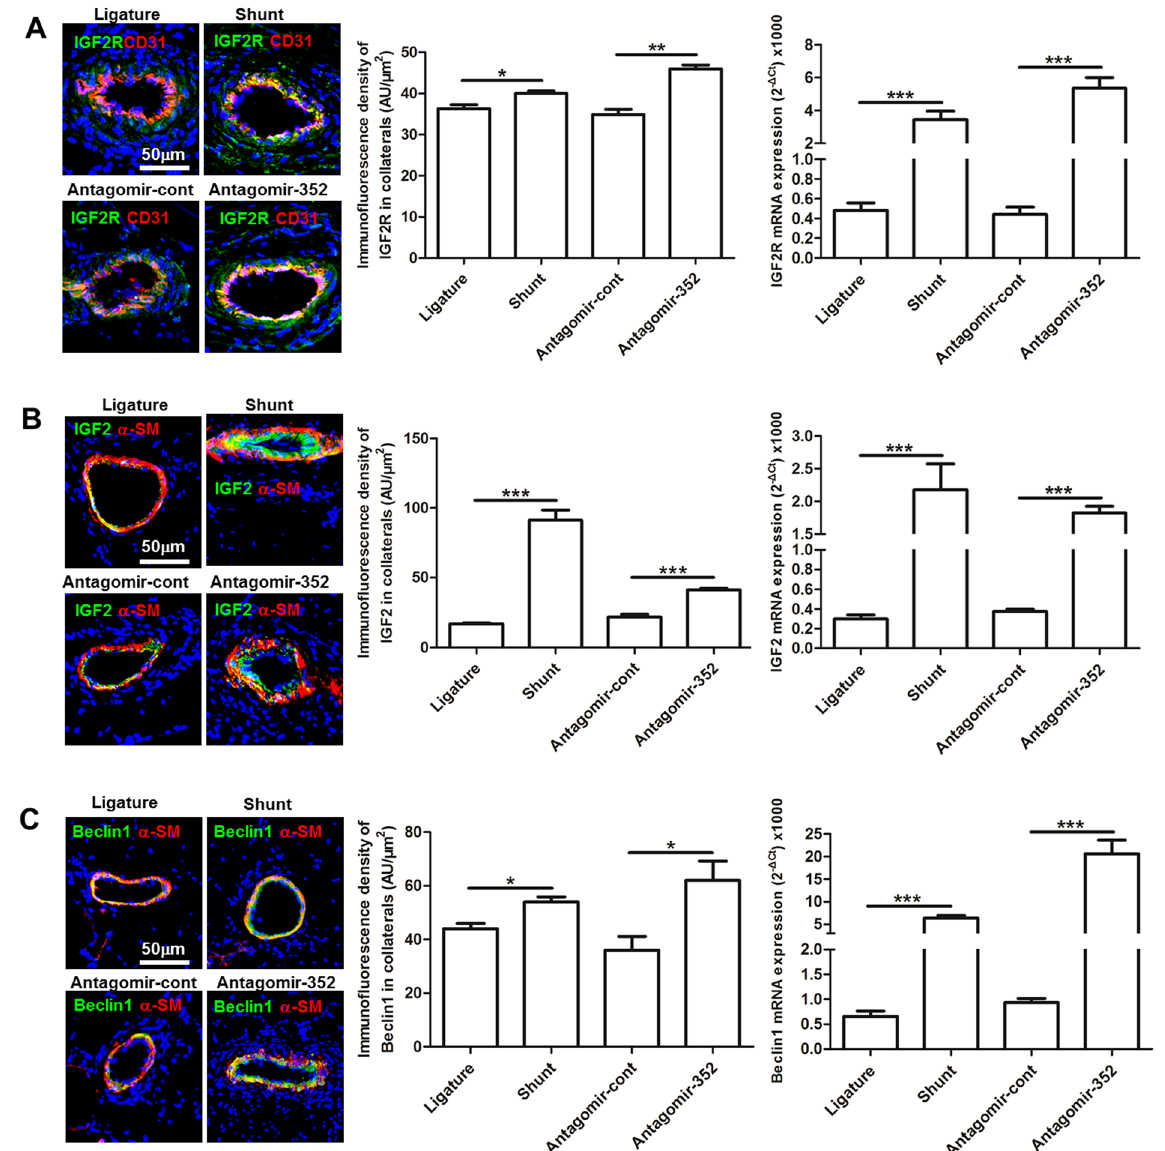
Figure 6. Effect of FSS and antagomir-352 on the expression of IGF2R, IGF2 and Beclin1 in collateral vessels of rat hind limbs. ( A ) IGF2R immunostaining and qPCR. ( B ) IGF2 immunostaining and qPCR. ( C ) Beclin1 immunostaining and qPCR. Specific fluorescence in green; red fluorescence for CD31 in A and for α -SM-actin in ( B and C ) blue fluorescence labels nuclei. Ligature: ligature-only side; Shunt: AV-shunt side; antagomir-352: antagomir-352 treated-side; antagomir-cont: antagomir-352 control. Both shunting and antagomir-352 treatment up-regulated expression of IGF2R, IGF2 and Beclin1 ( *** P < 0.001, ** P < 0.01, * P < 0.05, n =